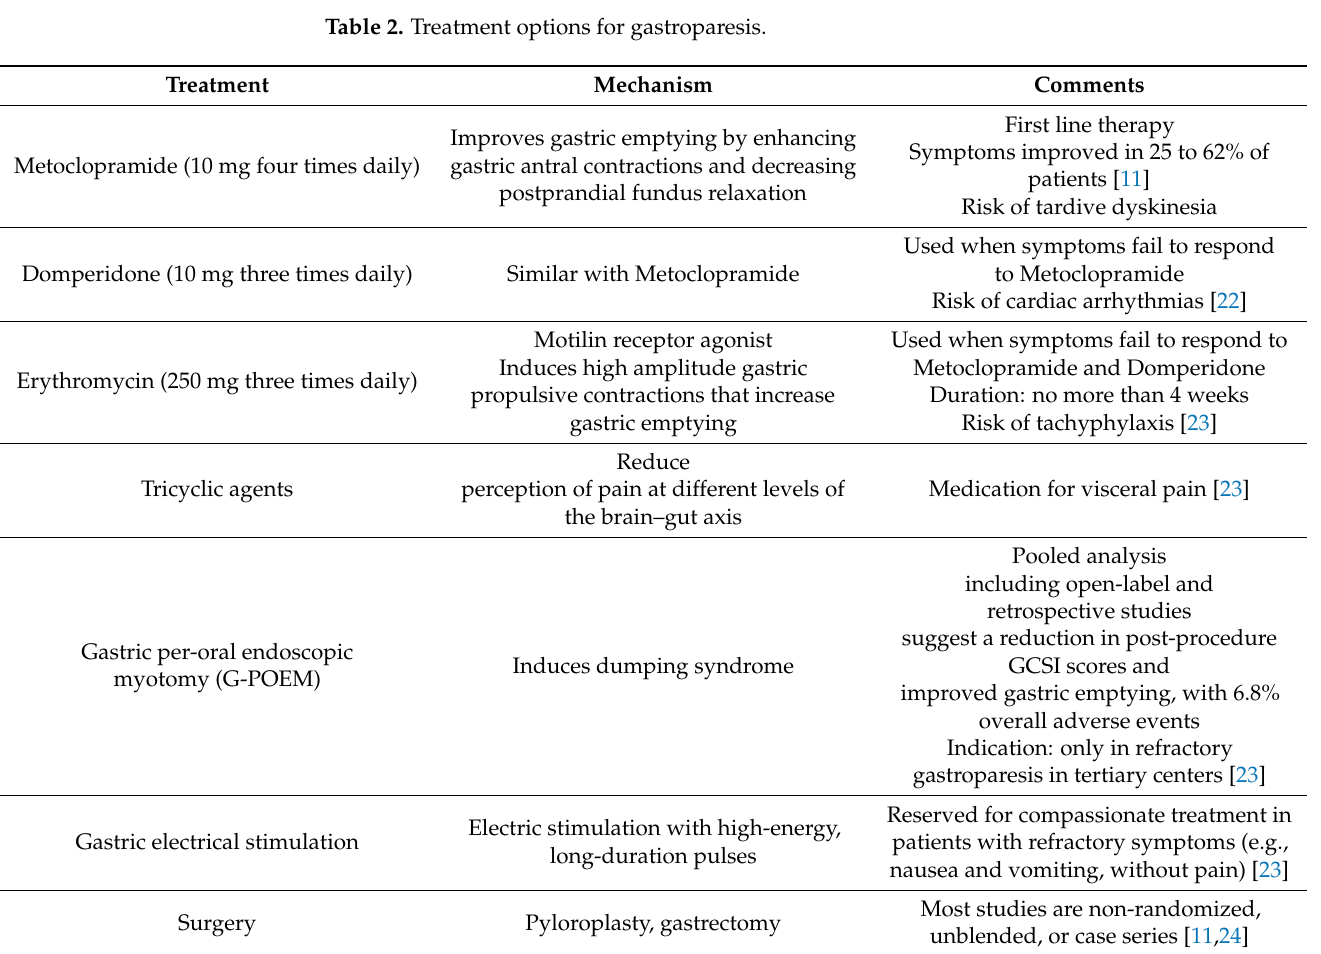
Table 2. Treatment options for